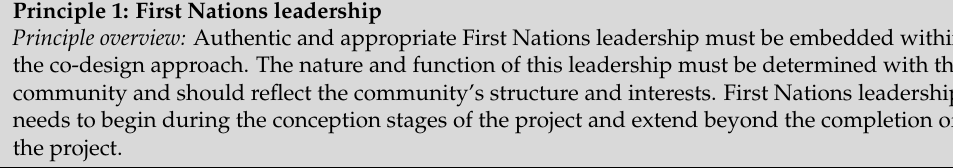
Table 2. Key Principles and Best Practices for co-design in health with First Nations